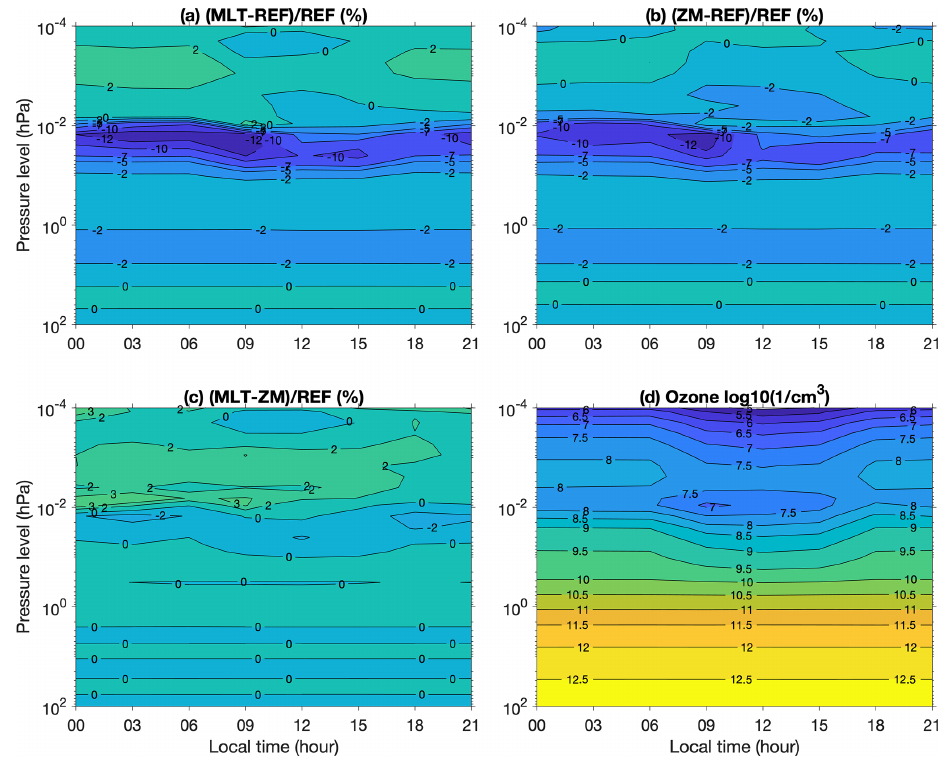
Figure 4. Southern Hemisphere (SH) polar-cap ozone. Local-solar-time (LST) means for August 2003. Panels (a) – (d) are as in Fig.